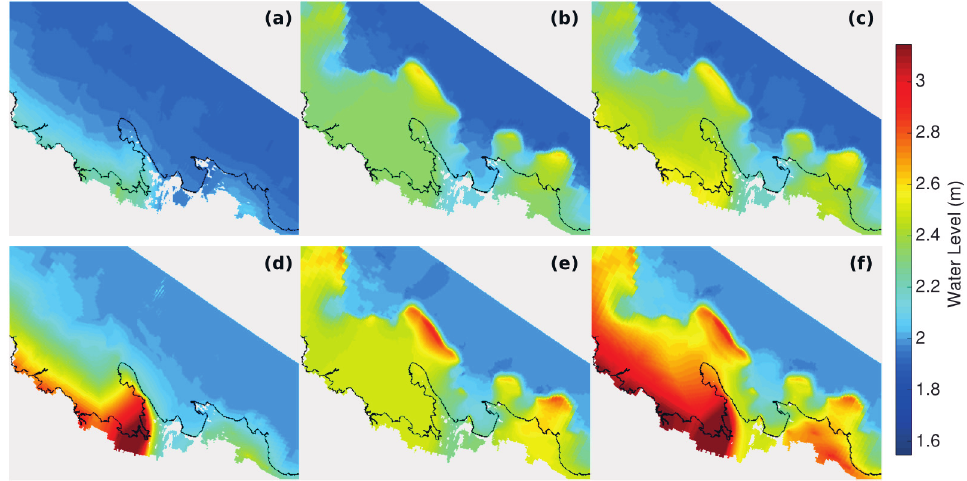
Figure 7. Water level maxima for the 100-year RI ensemble, “SLR” scenario. Median ensemble values for “wind” forcing ( a ); “wave” forcing ( b ); and “all forcing” ( c ); Subplots ( d – f ) are the same as ( a – c ) ensemble except are 95th percentile ensemble values.